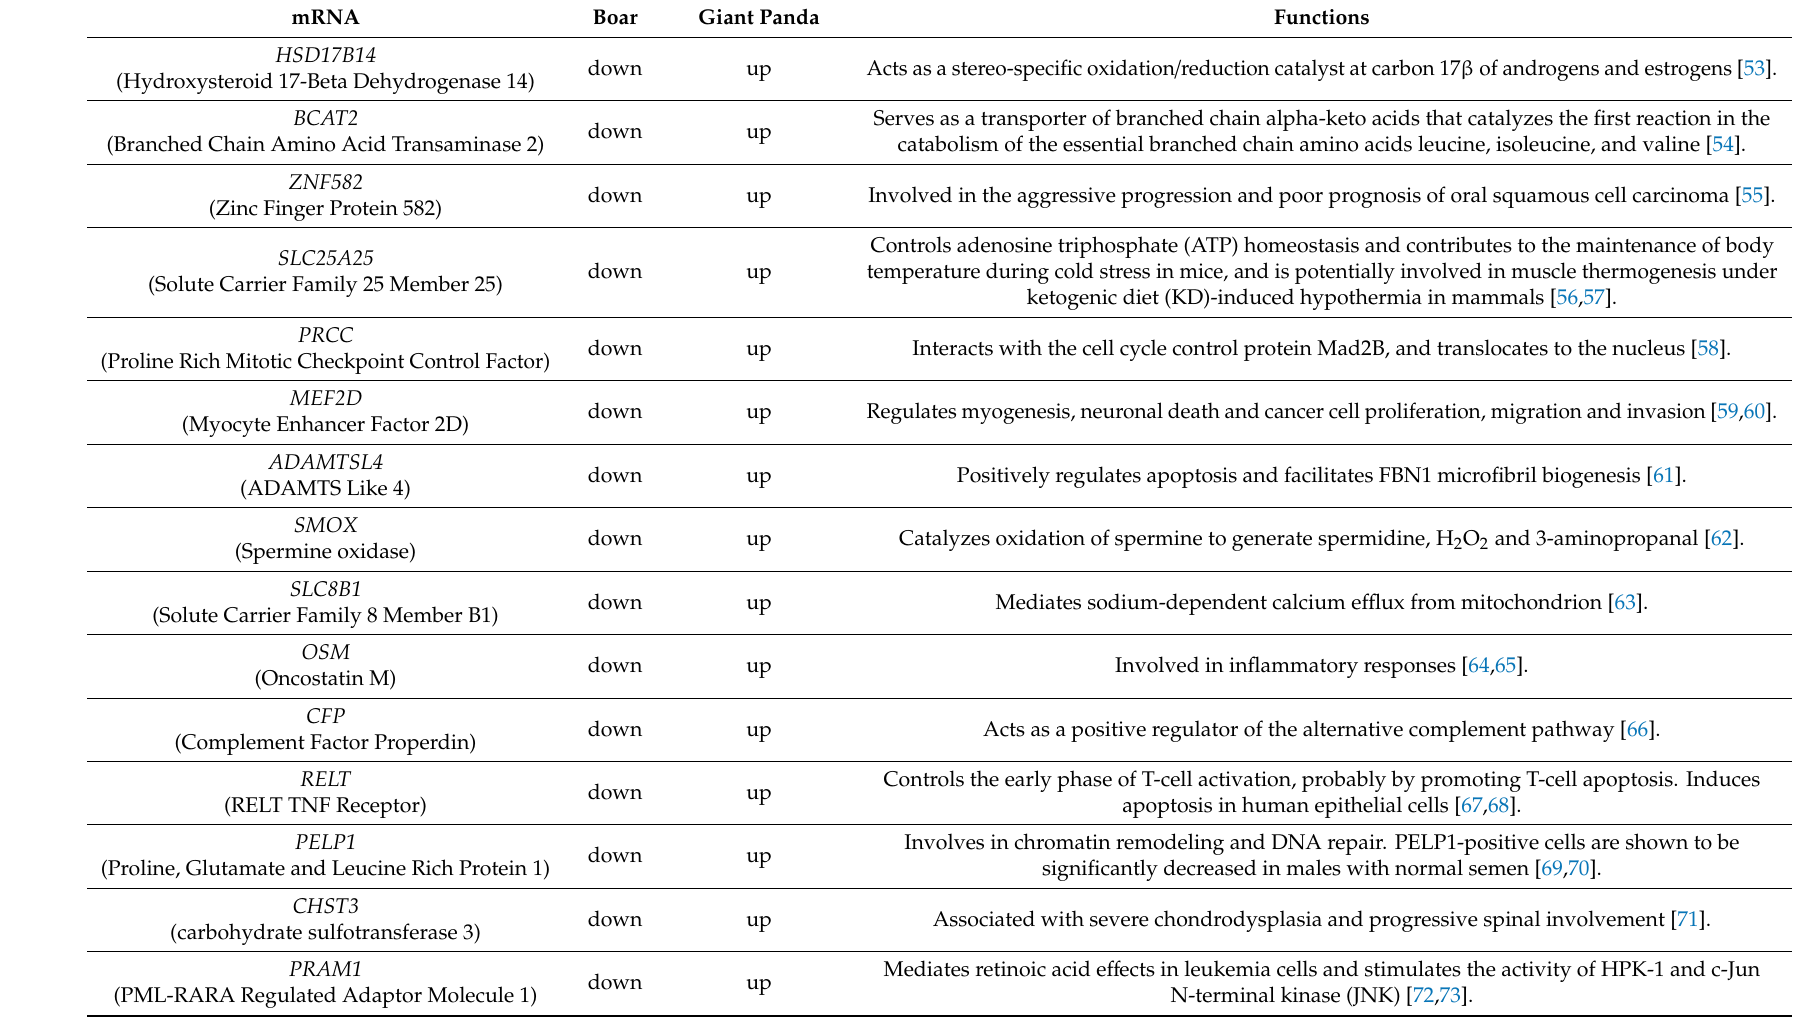
Table 4. The regulation of expression and the function of the DE mRNAs that exhibited the opposite trend of expression in boar and giant panda sperm.